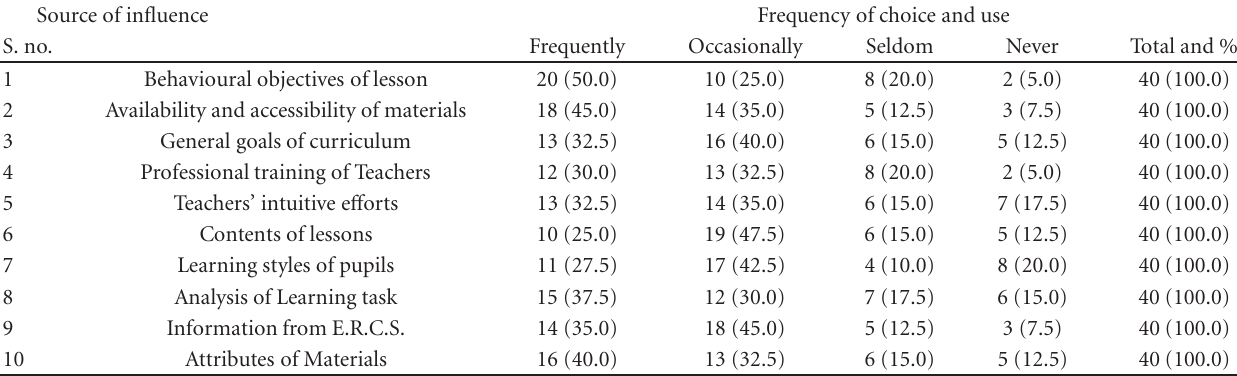
Table 3: Assessment of sources of influence on teacher’s choice and use of